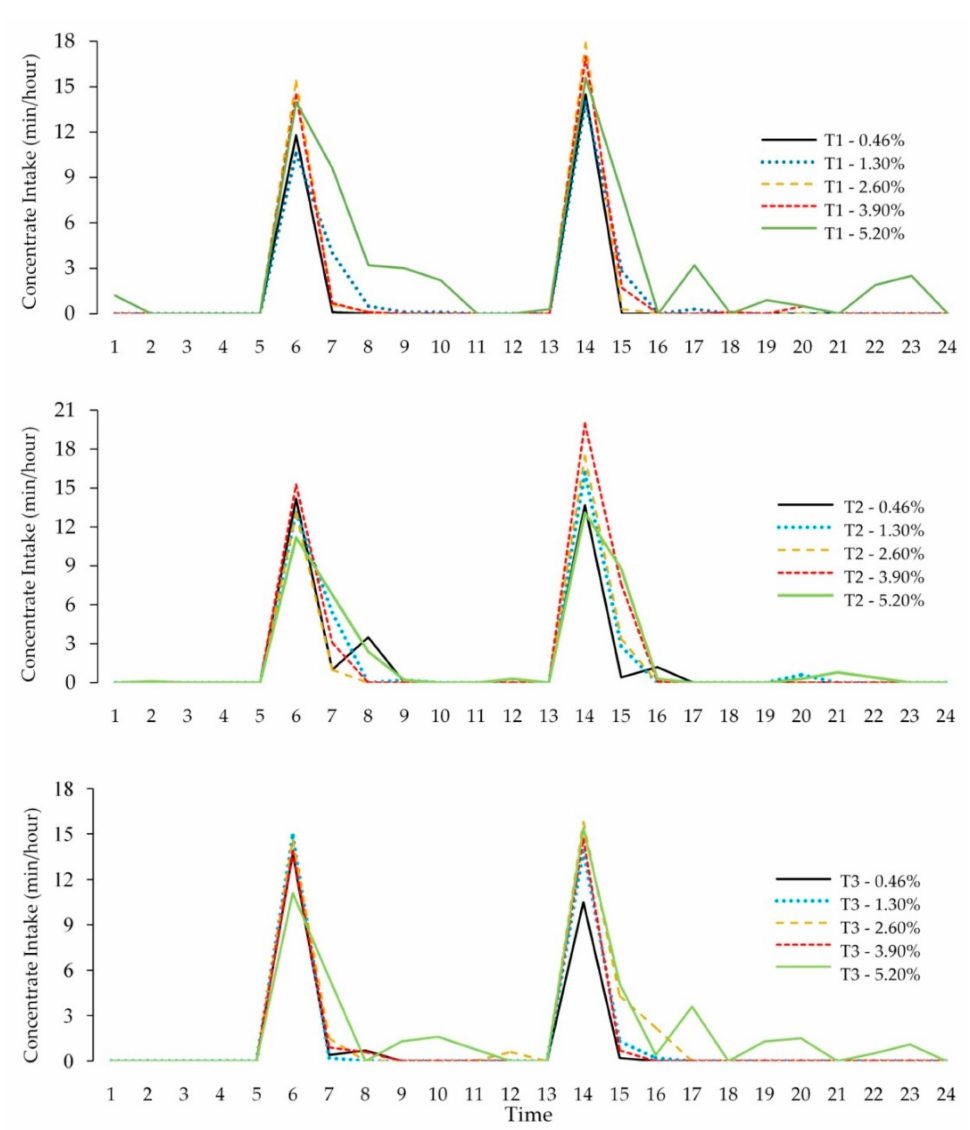
Figure 2. Daily time of concentrate intake at three different Times (T1, T2, and T3) in the experimental periods by lactating dairy cows fed diets containing different tannin